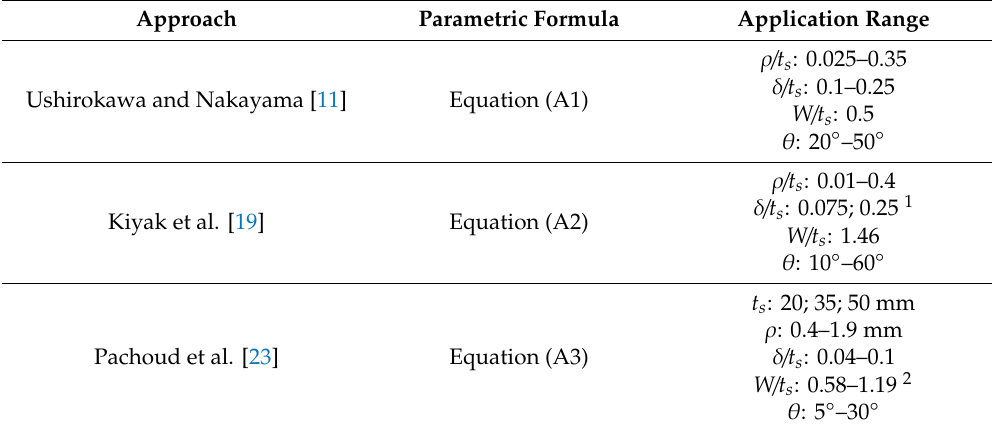
Table 1. Elastic stress concentration factor (SCF) ( K t ) parametric formulae for butt-welded joints loaded in tension.